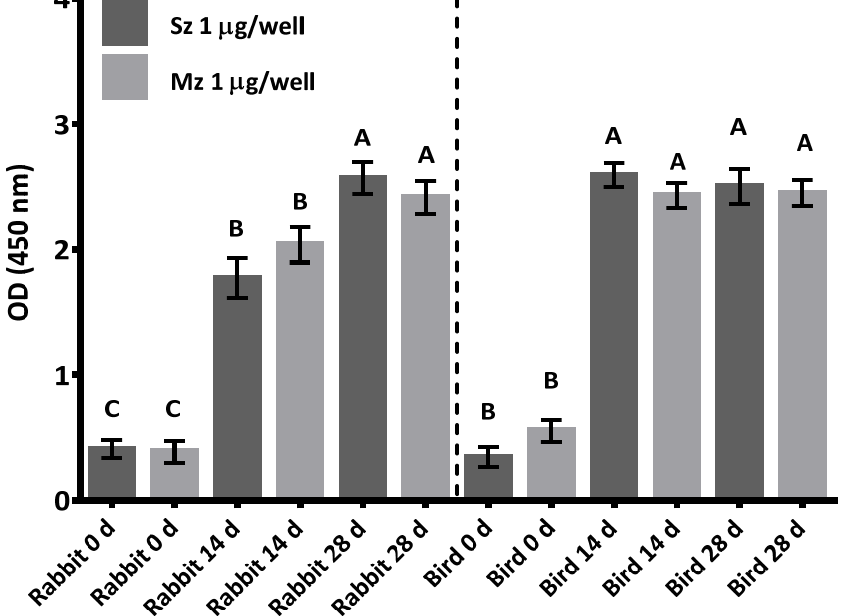
Figure 2. Dynamics of antibody production against two life cycle stages of E. tenella (Sz and Mz) in rabbits and SPF birds at 0, 2, and 4 weeks after immunization with whole sporozoites of E. tenella . Preimmune sera (0 d) were collected prior to the first immunization. The rabbit and SPF chicken antisera were diluted 1:100. Bars represent mean values with respective SDs. Different letters on same type of antigen indicate statistical differences at p < 0.05.